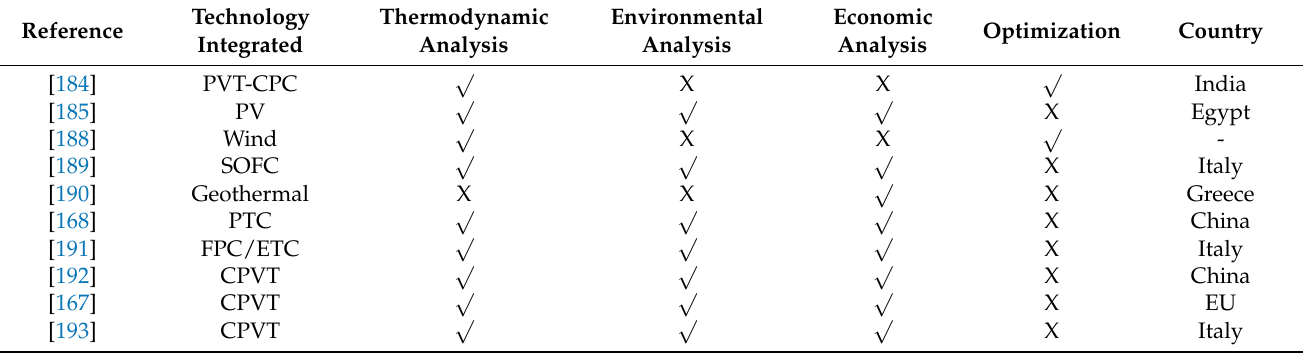
Table 6. Literature works on biomethane plants integrating renewable energies: methodological approaches.